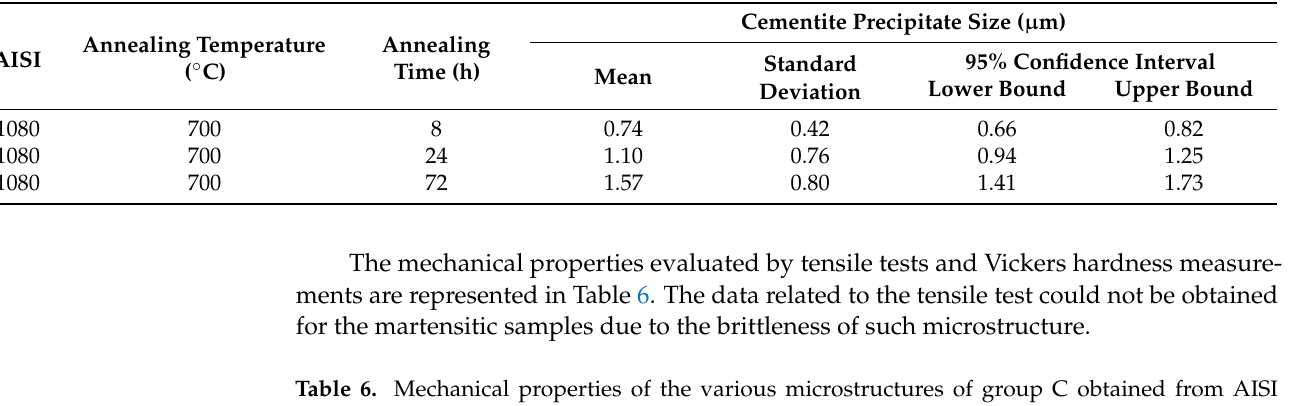
Table 5. Mean size of spheroidized precipitates of samples annealed at different soaking times.